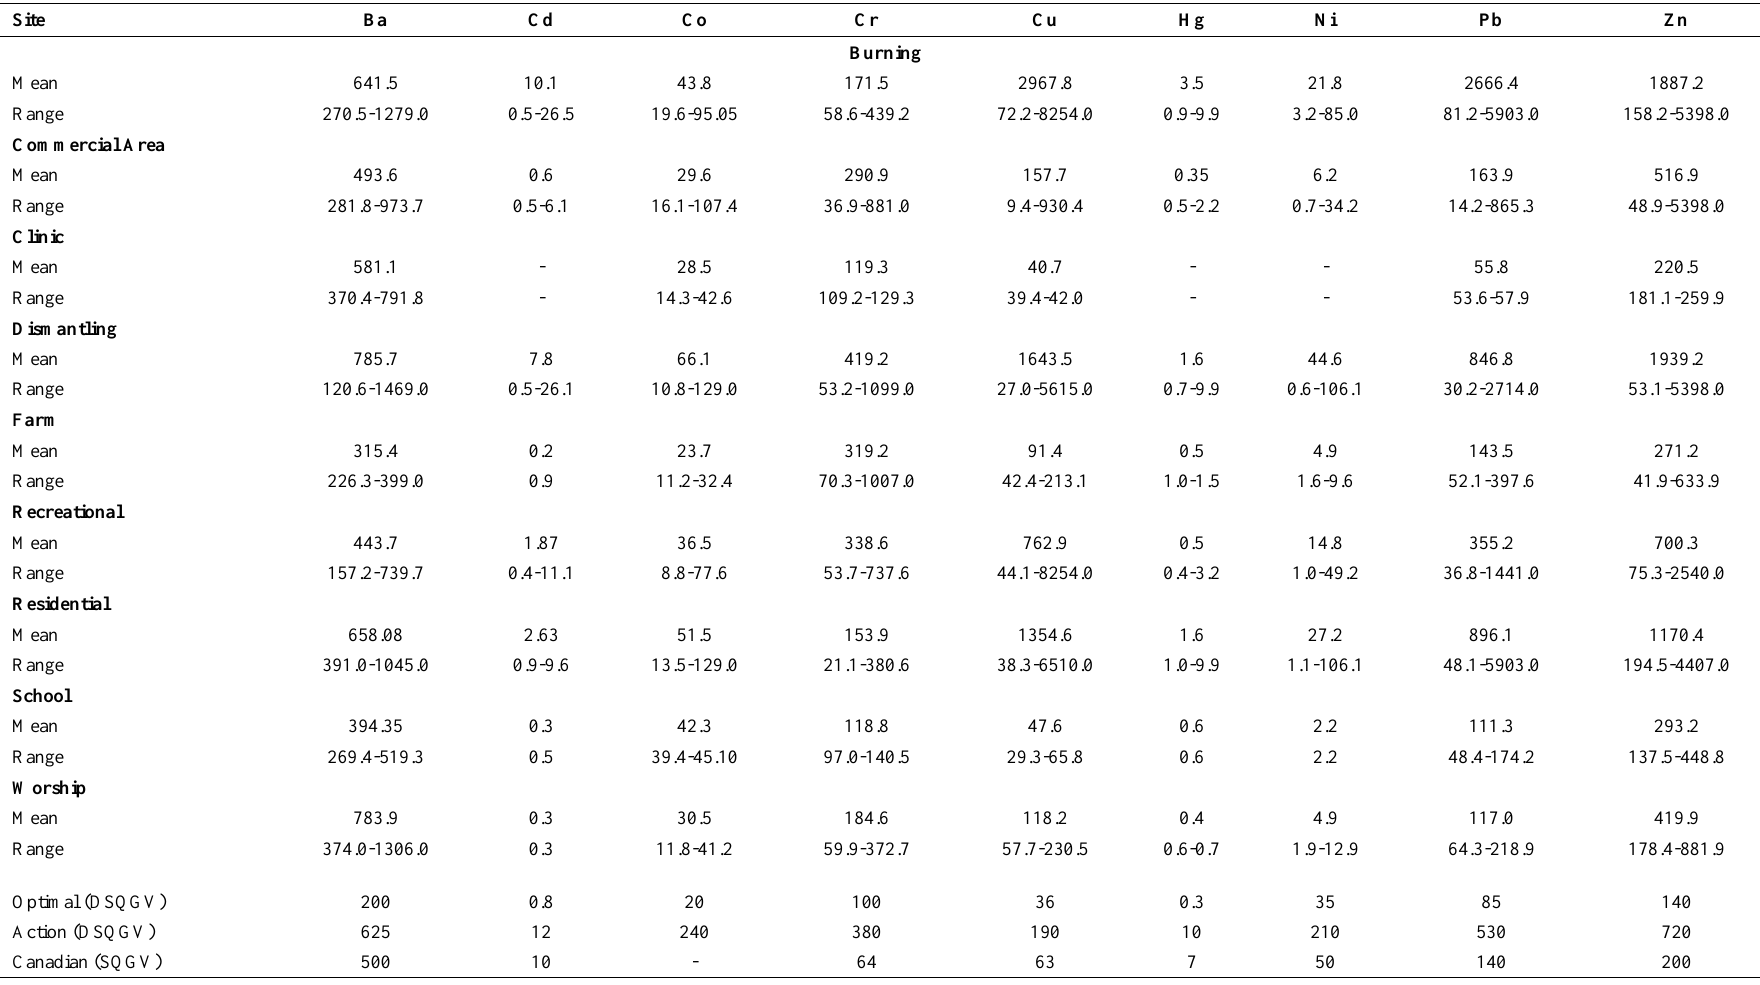
Table 1. Concentrations of heavy metals in soil at AEPS